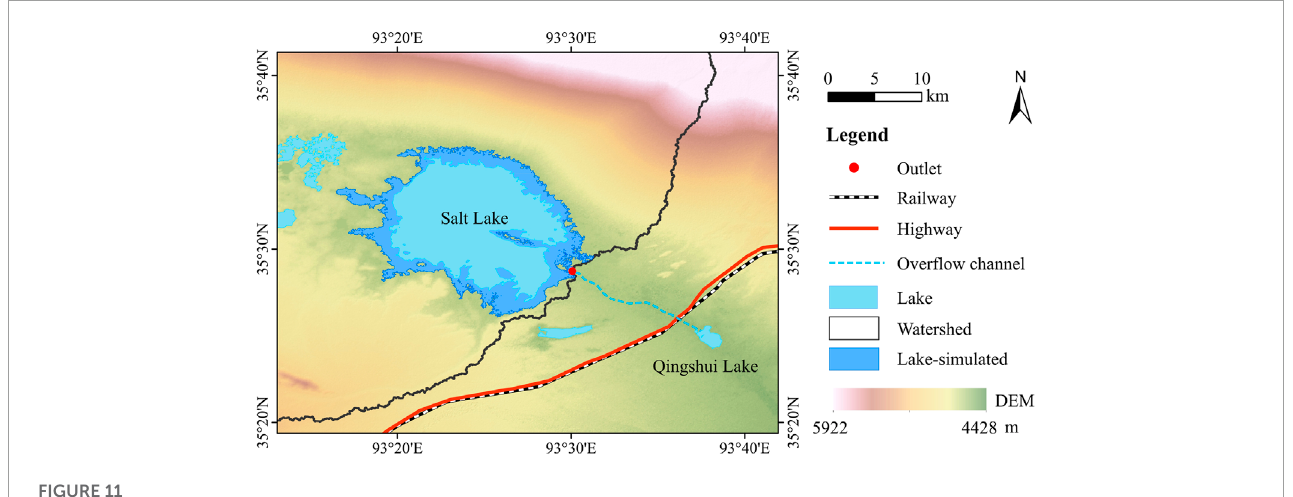
FIGURE 11 The maximum expansion area of the Salt Lake before overflow.